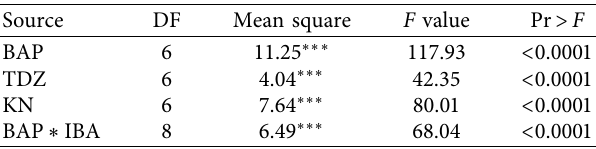
Table 7: ANOVA summary of effect of BAP, TDZ, KN, and BAP ∗ IBA on in vitro shoot multiplication of A. corrorima . Source DF Mean square F value Pr > F BAP 6 11.25 ∗∗∗ 117.93 < 0.0001 TDZ 6 4.04 ∗∗∗ 42.35 < 0.0001 KN 6 7.64 ∗∗∗ 80.01 < 0.0001 BAP ∗ IBA 8 6.49